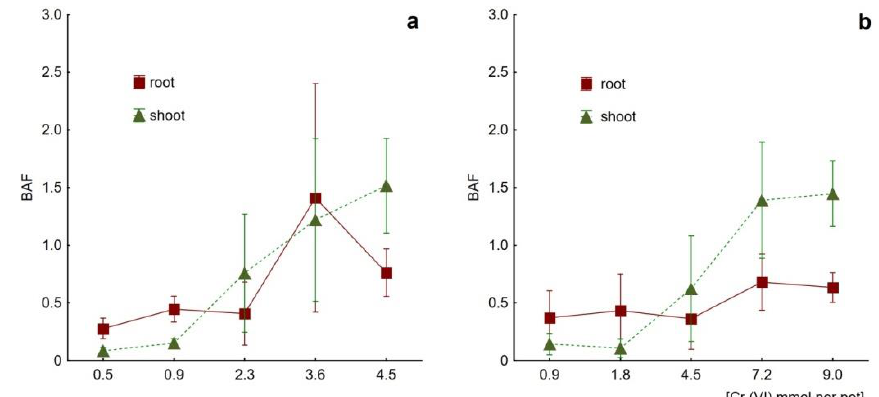
Figure 5. Chromium content in ( a ) roots and ( b ) shoots of Mesembryanthemum crystallinum plants subjected to Cr(VI) applied as potassium dichromate, K 2 Cr 2 O 7 , at the doses of 0.9, 4.5, 7.2 and 9.0 mmol per pot (untreated control at dose 0). Different letters above the bars indicate statistically significant differences at p ≤ 0.05.